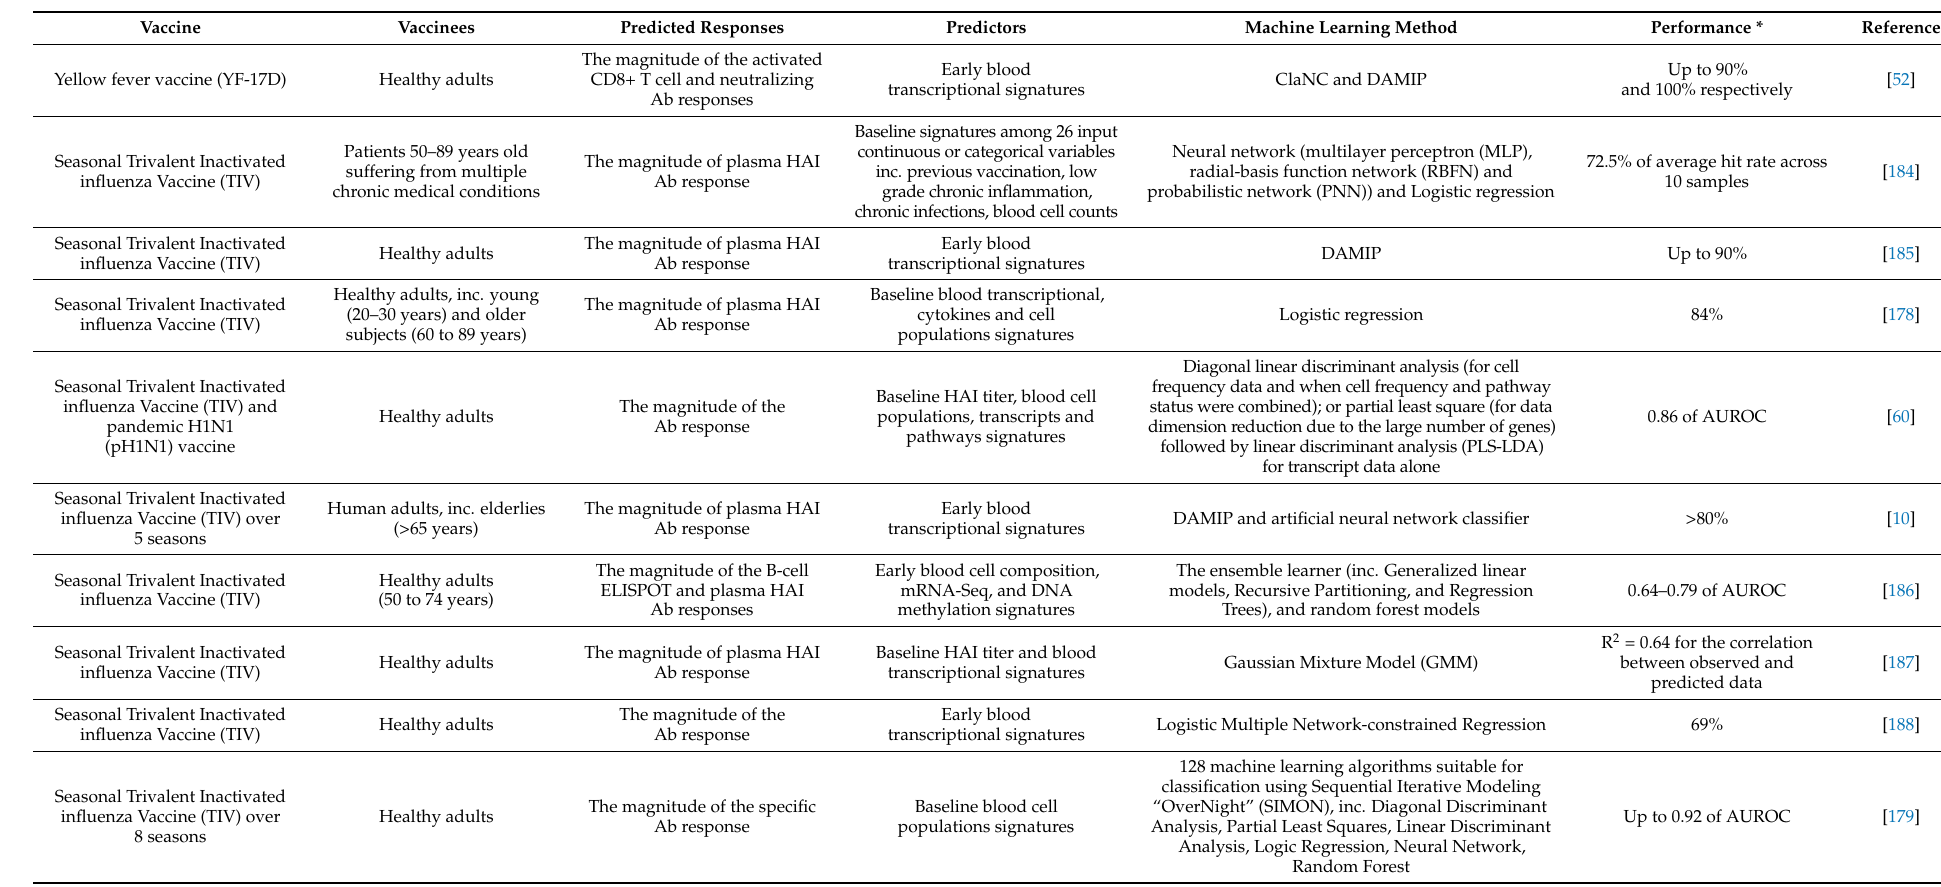
Table 2. Machine learning methods to predict vaccine immunogenicity and efficacy. Different machine learning algorithms can be used. The quality of the model needs to be evaluated, and there are different metrics to assess a model performance, such as accuracy (defined as the number of correct predictions divided by the total number of input data), Area Under the Receiver Operator Characteristic curve (AUROC) or Root Mean Squared Error for regressions. It depends on the machine learning method itself. (Ab, antibody; ClaNC, classification to nearest centroid; DAMIP, discriminant analysis via mixed integer programming; HAI, hemagglutination-inhibition; CHMI, Controlled Human Malaria Infection; * accuracy except otherwise